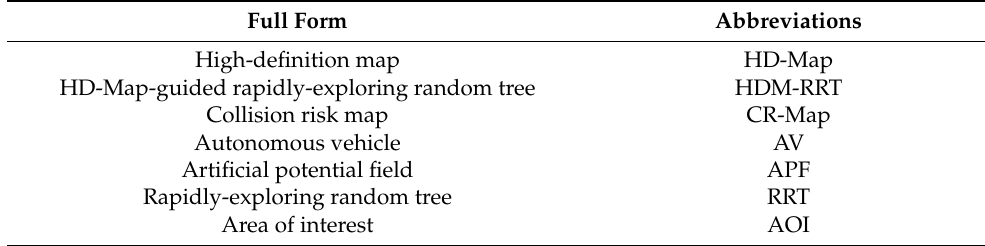
Table 2. The main abbreviations in the